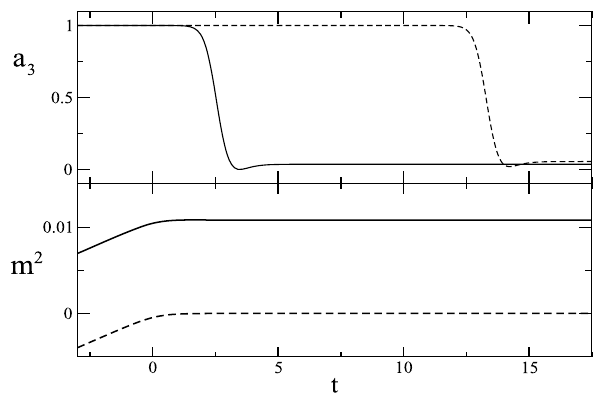
Fig. 2 Flow of the parameter a 3 (upper panel) and of the square mass m 2 = g 2 in the region around t ∼ 0 and in the IR region with t > 0. Boundary values are taken at t = − 3, with m 2 = 0 . 007 and g 3 = g 4 = 0 . 1 in one case (solid lines) and m 2 (cid:11) − 0 . 004, g 3 = 10 − 15 , g 4 = 0 . 1 in the other case (dashed lines). As clarified in the text, diagrams containing vertices g n , with n > 4, are neglected in this case and all plots do not depend on n in